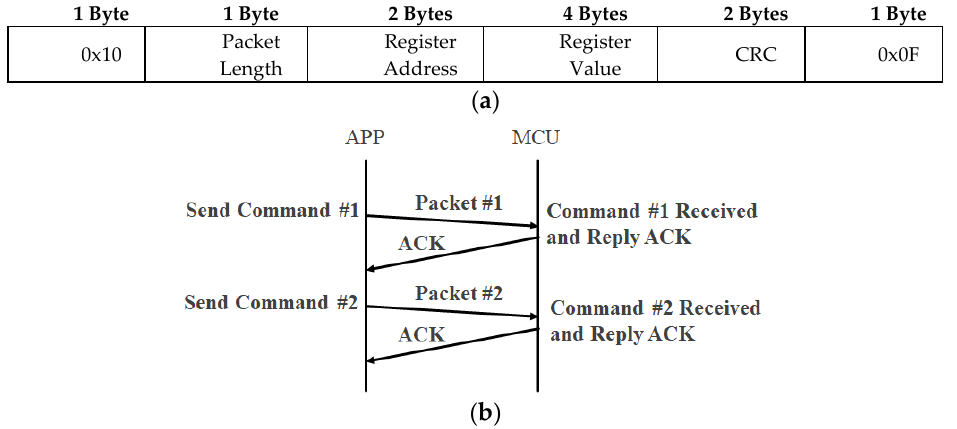
Figure 4. The proposed self-defined Bluetooth packet format and ACK mechanism: ( a ) SBPF and ( b ) schematic diagram of the handshake of the ACK mechanism.